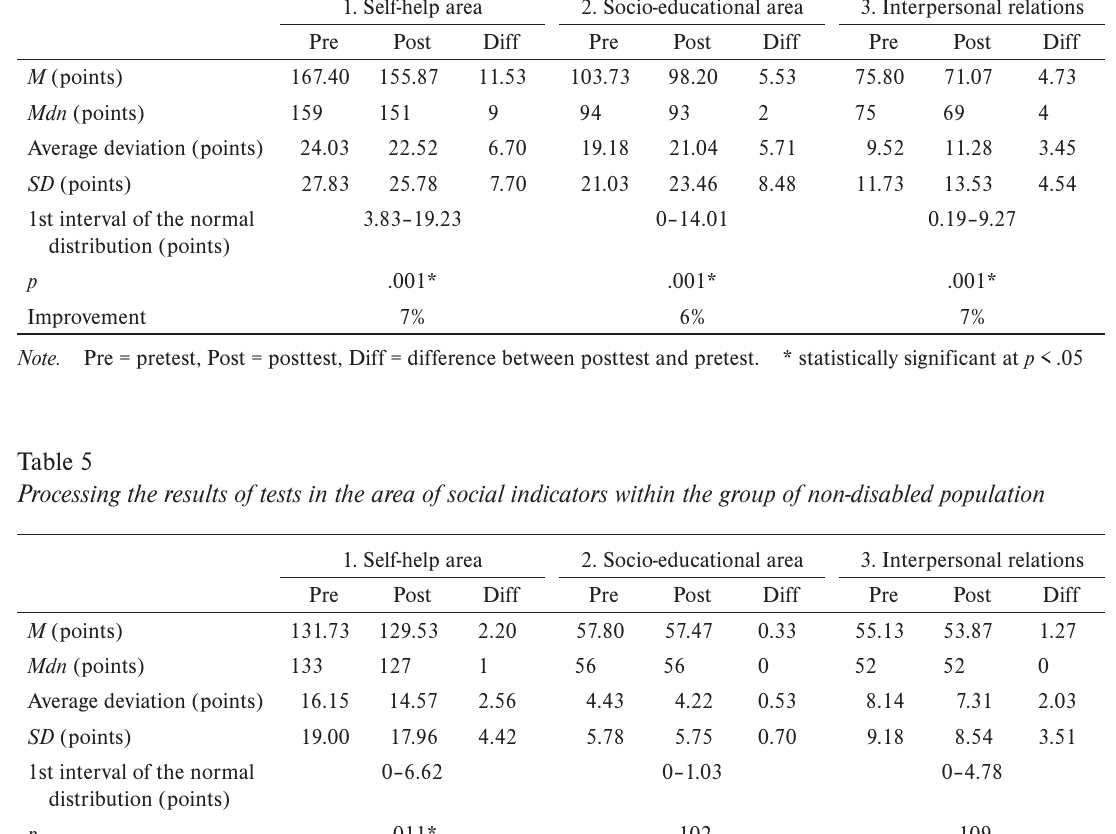
Test results in social areas in a group of children with intellectual disabilities 1. Self-help area 2. Socio-educational area 3. Interpersonal relations